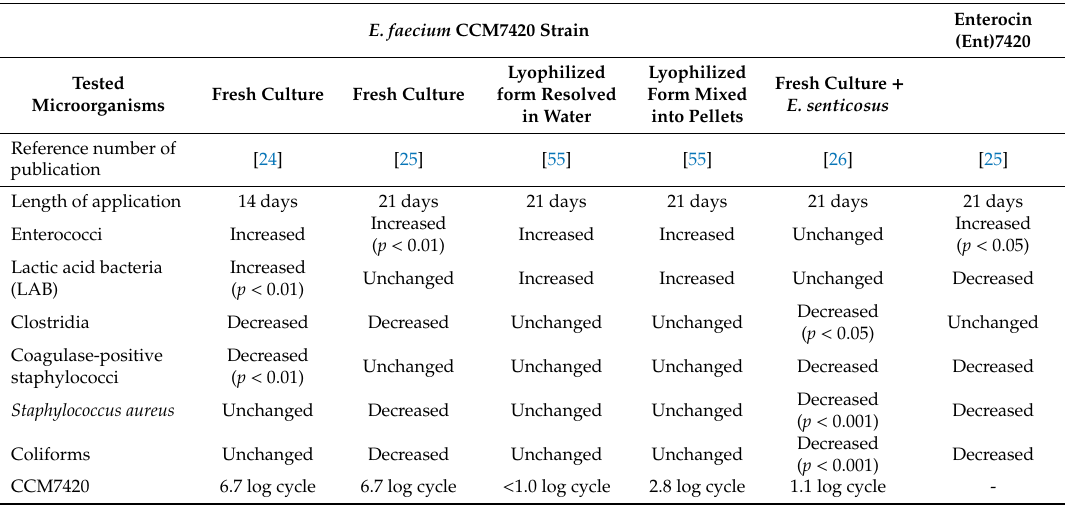
Table 2. The e ff ect of Enterococcus faecium CCM7420 and its enterocin Ent7420 on the fecal microbiota of